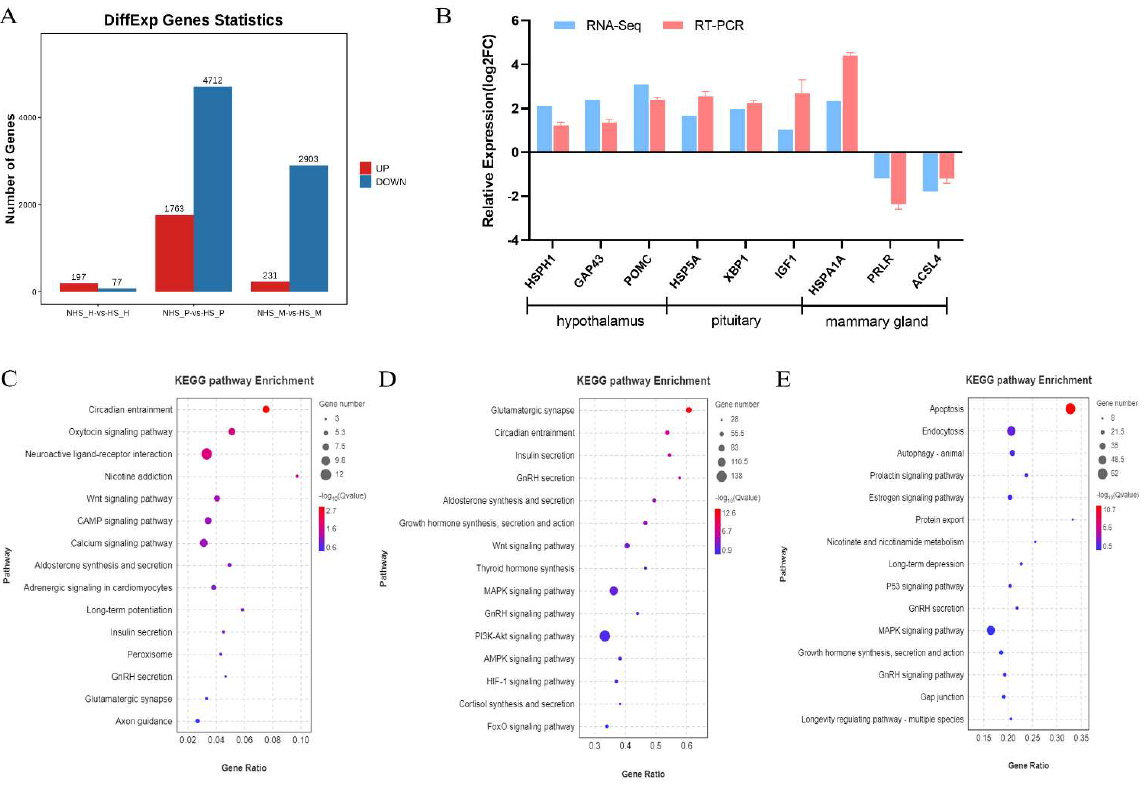
Figure 7. ( A ) Statistics of differential expression of mRNAs. ( B ) Comparison of the mRNAs expression levels determined by RNA-seq and RT-qPCR. ( C – F ) KEGG pathway analysis on the DE mRNAs in the hypothalamus, pituitary and mammary gland in dairy cows under heat stress.